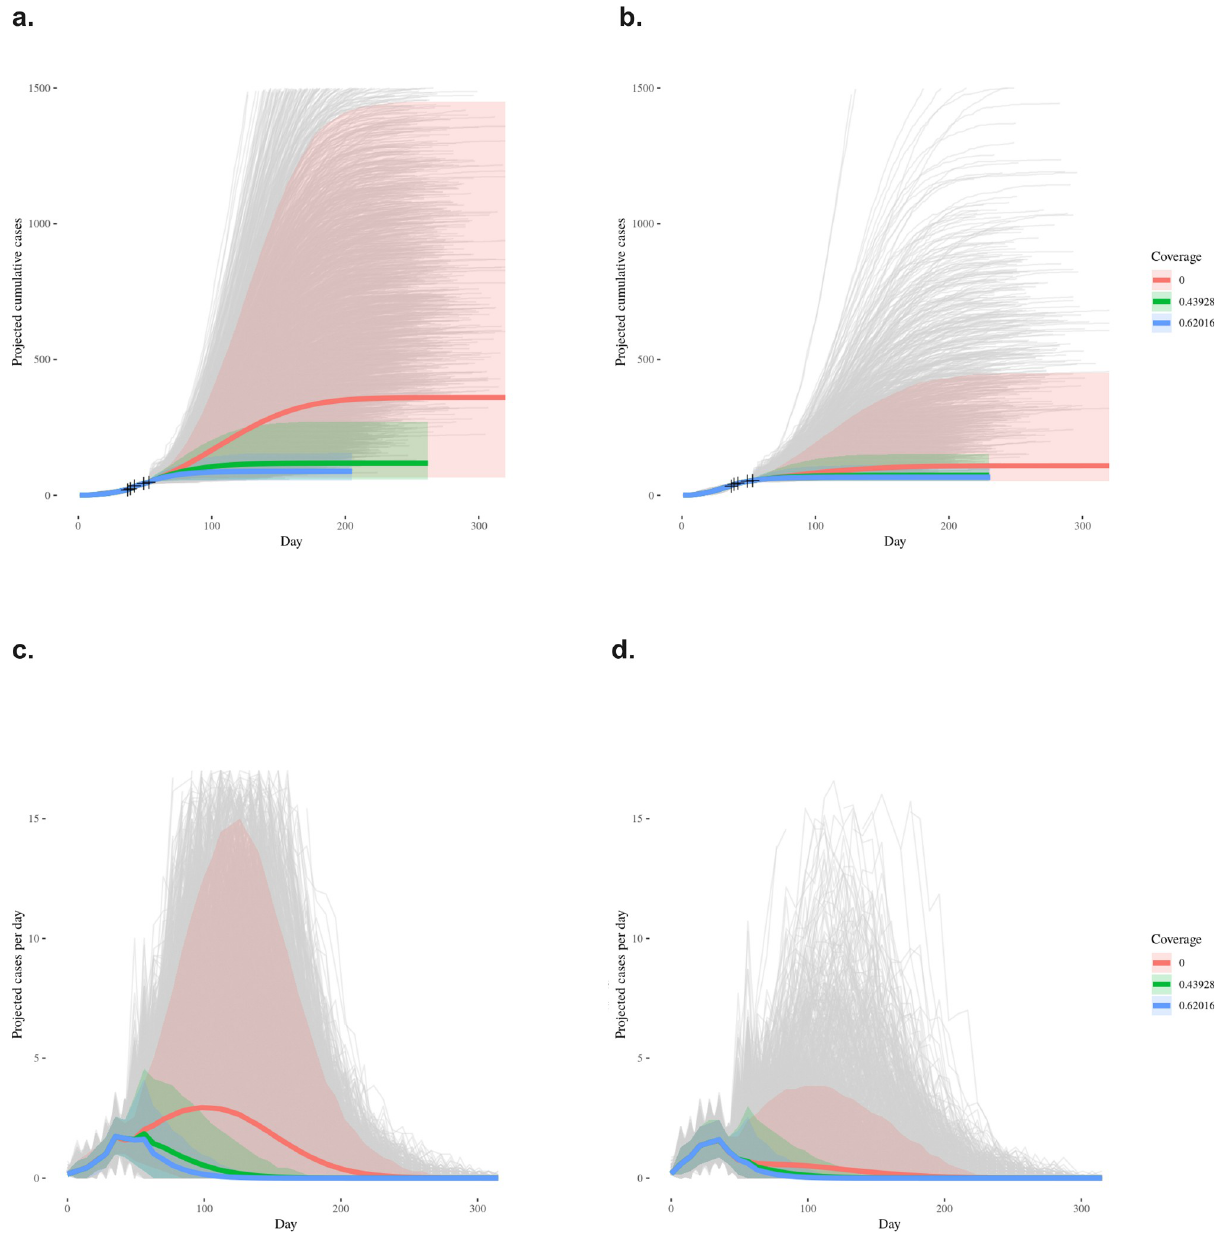
Fig 3. Distribution of outbreak projections from stochastic branching process model. a. Mean and prediction interval of cumulative probable/ confirmed case count by day in model projections, by proportion of vaccine coverage. Target case numbers and dates are marked with + signs; b. Mean and prediction interval of cumulative probable/confirmed/suspected case count by day in model projections, by proportion of vaccine coverage. Target case numbers and dates are marked with + signs; c. Mean and prediction interval of weekly average of per-day probable/confirmed case count in model projections; and d. Mean and prediction interval of weekly average of per-day probable/confirmed/suspected case count in model projections.